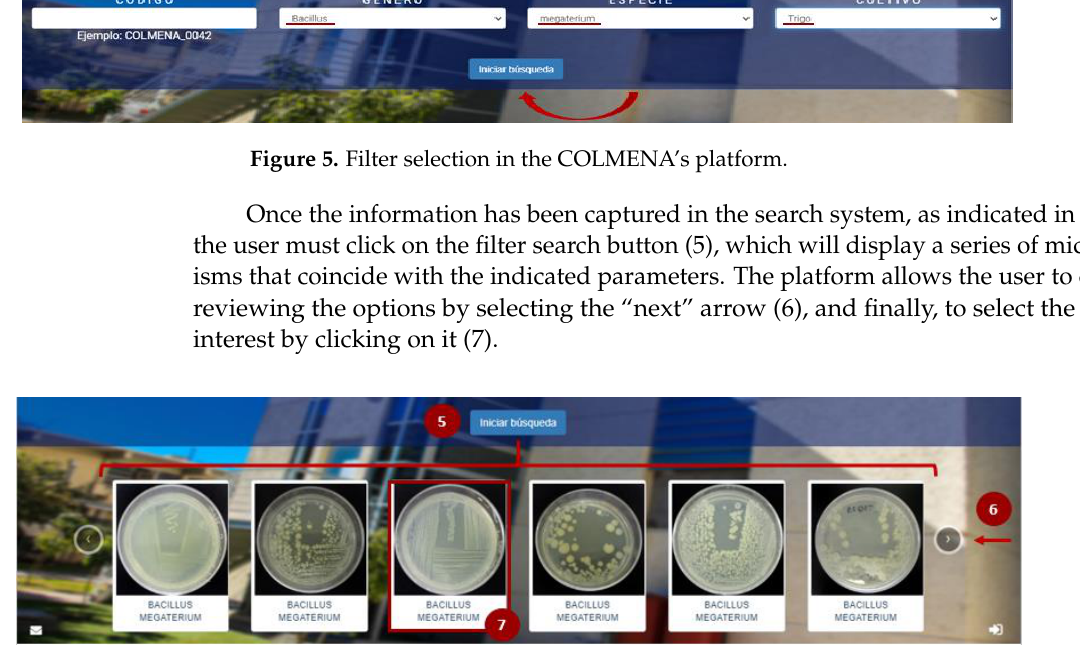
Figure 6. Strain search results in the COLMENA’s platform.